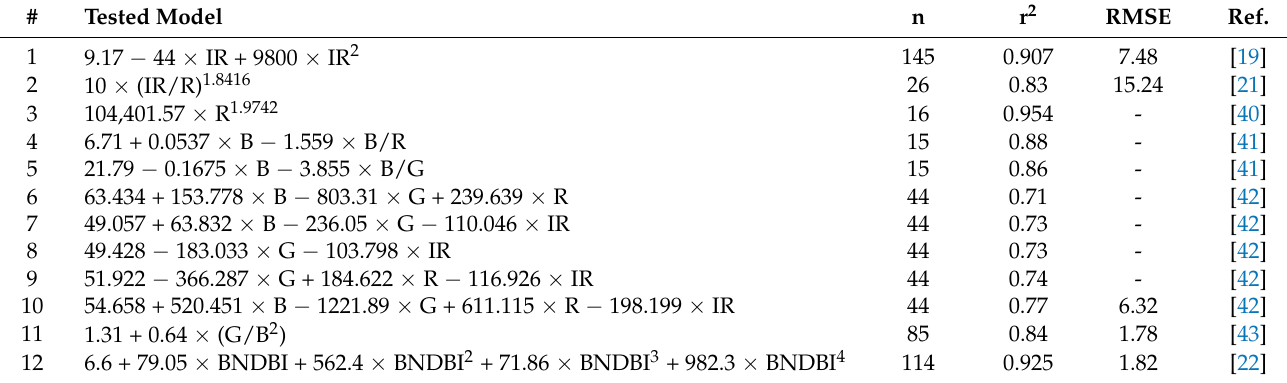
Table 3. Regression models for the estimation of chlorophyll-a concentration that was tested in this study. The models’ result and the RMSE values are in micrograms per liter ( µ g/L). B, G, R, and IR stand for the reflectance at the blue, green, red, and near infrared